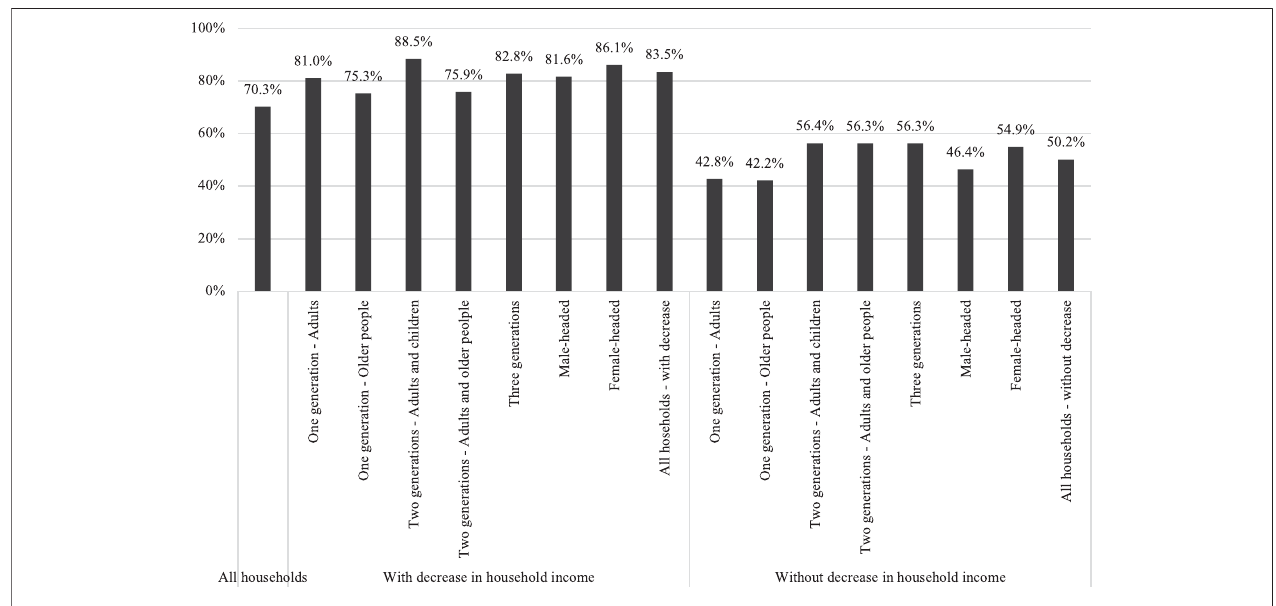
FIGURE 4 | Households reporting having adopted at least one income-generating strategy by household composition and headship. Notes: Sample weights applied. Differences by income-generating strategies and household headship among households with decrease in household income are signi fi cantat p < 0.05.Differencesbyincome-generatingstrategiesandhouseholdheadshipamonghouseholdswithoutdecreaseinhouseholdincomearesigni fi cantat p < 0.01.Differencesbyincome-generatingstrategiesandhouseholdcompositionamonghouseholdswithdecreaseinhouseholdincomearesigni fi cantat p < 0.001. Differences by income-generating strategies and household composition among households without decrease in household income are signi fi cant at p < 0.001.